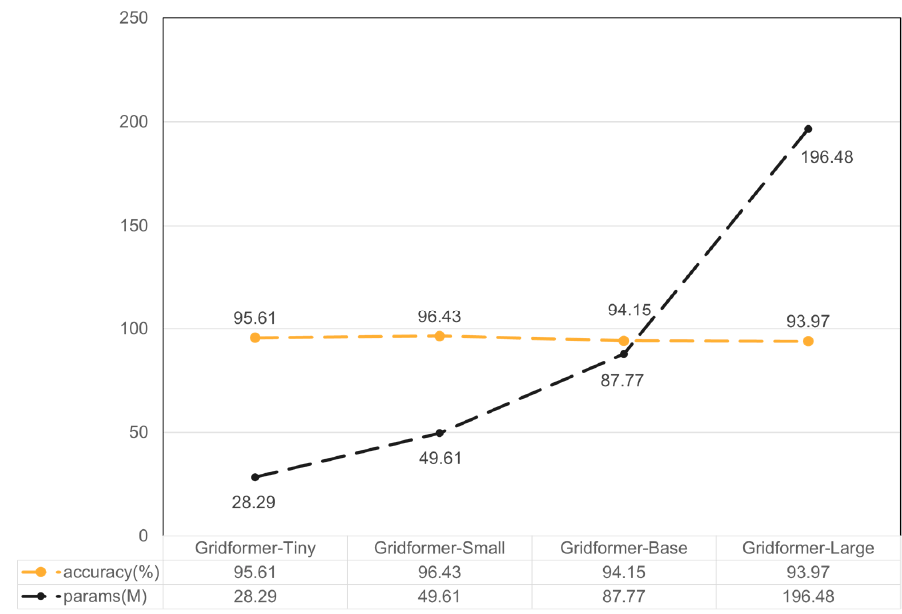
Figure 16. Comparison of different scales of Gridformer.